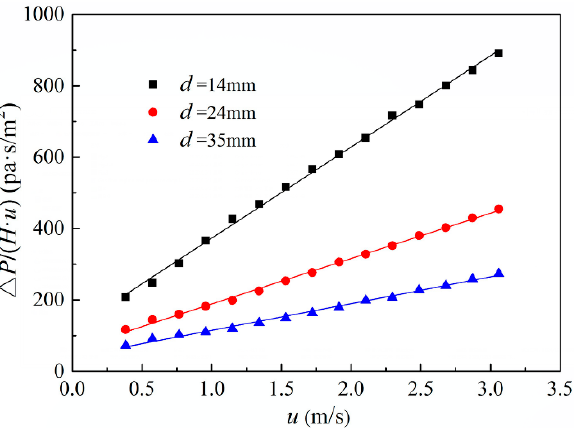
Figure 2. Changes in the modified pressure drop per unit height with gas superficial velocity.